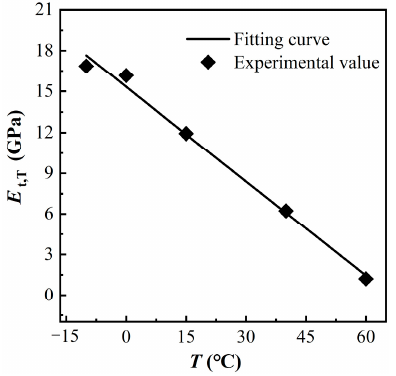
Figure 16. Relationship between tensile elastic modulus and temperature.